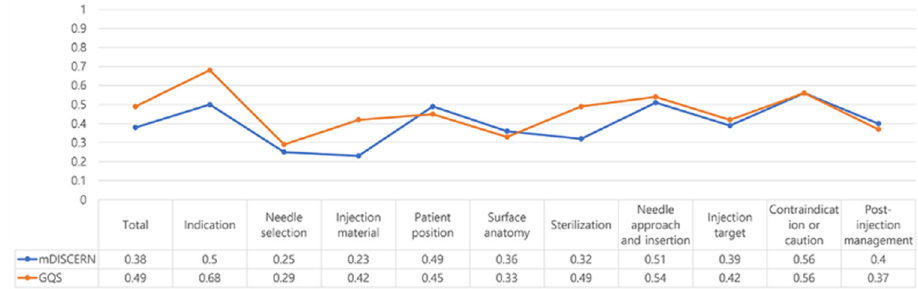
Figure 4. Correlation coefficients of the 10 shoulder injection score domains between the modified DISCERN and global quality score.